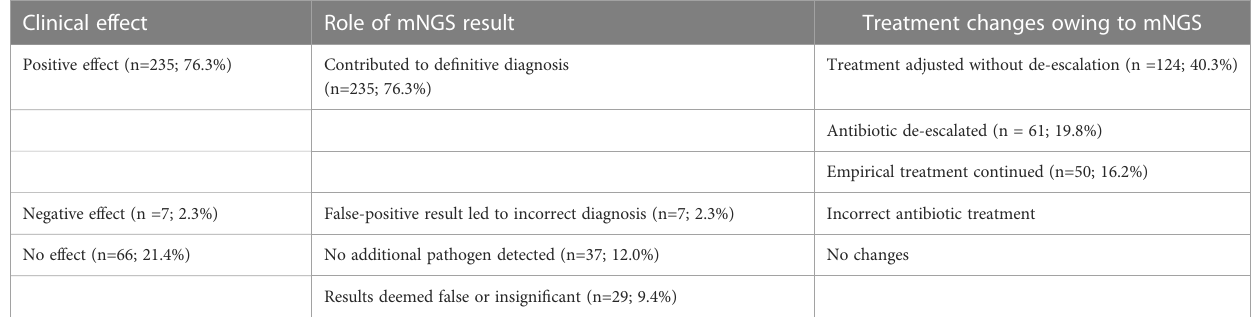
TABLE 4 Clinical effects of mNGS results on diagnosis and